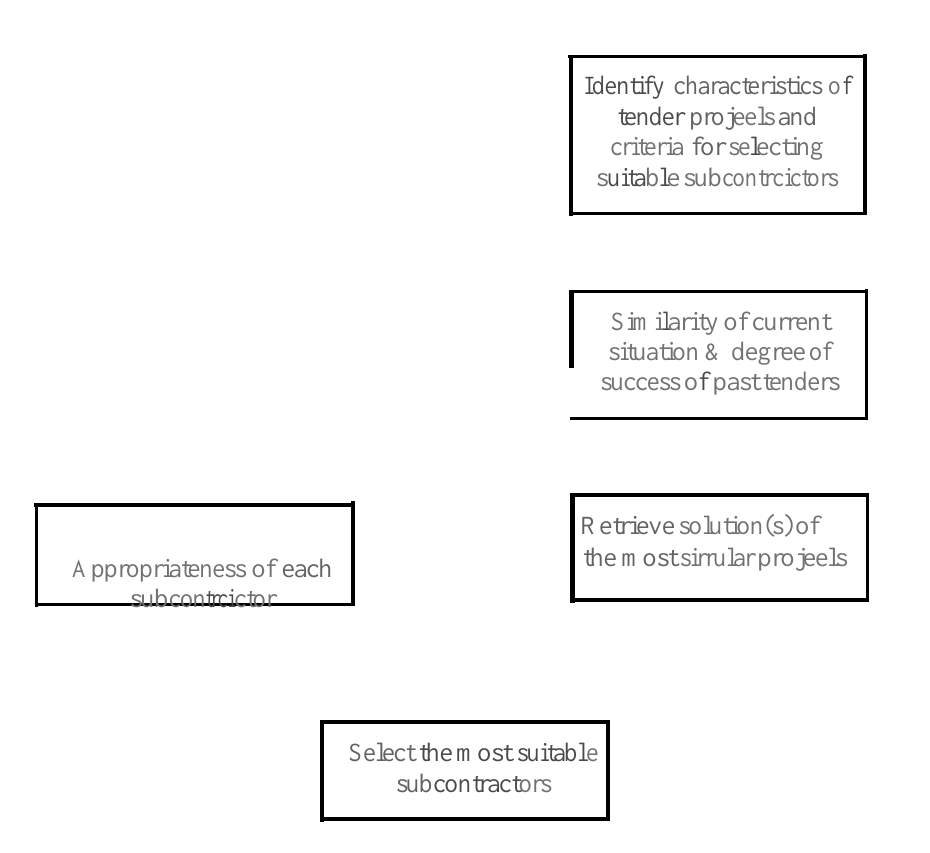
Figure 1: Process of Selecting Subcontractors for Tendering